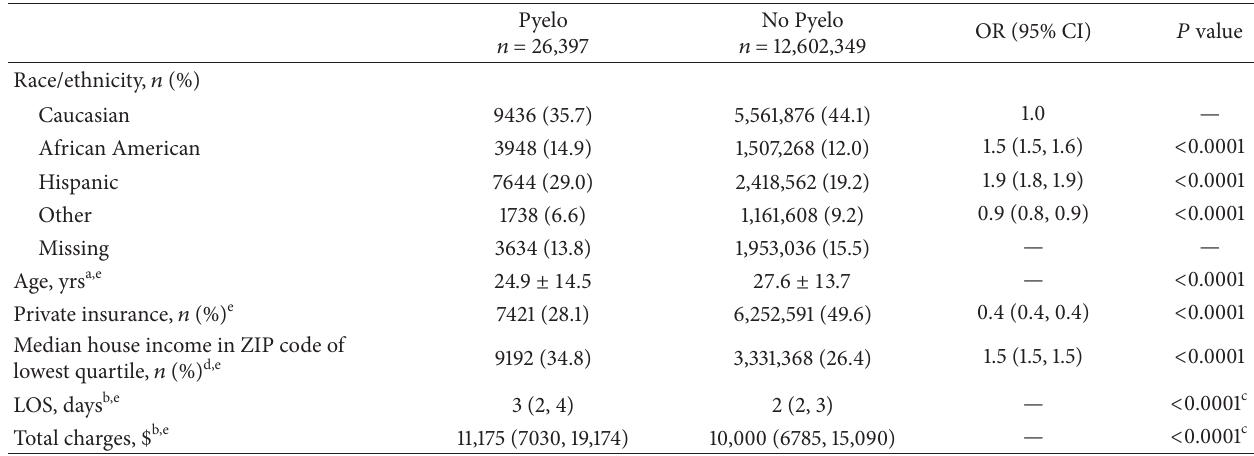
Table 1: Demographic data at the time of delivery in hospital discharges among women with pyelonephritis compared to women without pyelonephritis, Nationwide Inpatient Sample years 2008–2010 (12,628,746